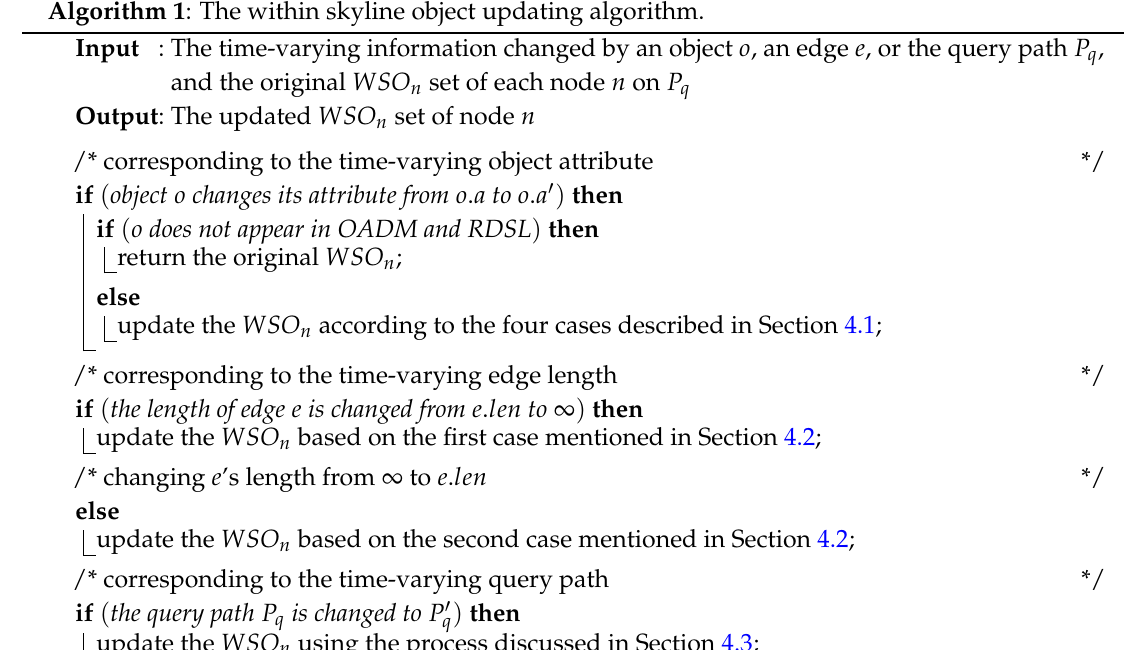
Algorithm 1 : The within skyline object updating